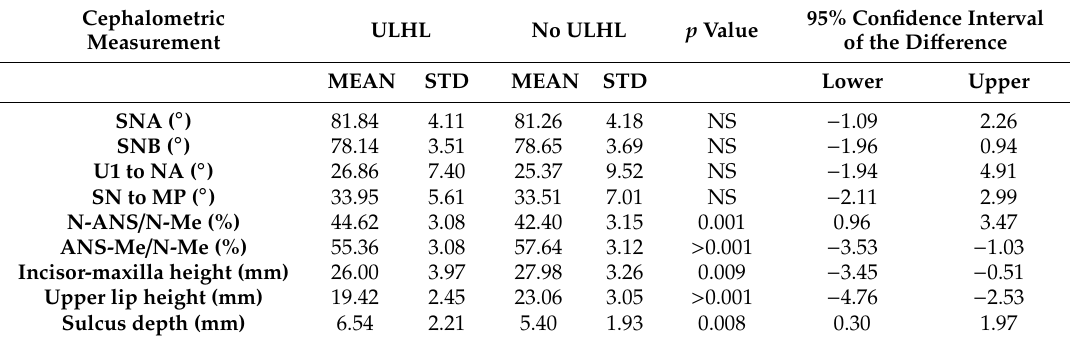
Table 4. Cephalometric measurements of the study group with and without ULHL, T-test analysis was used to describe the di ff erences between the two groups.